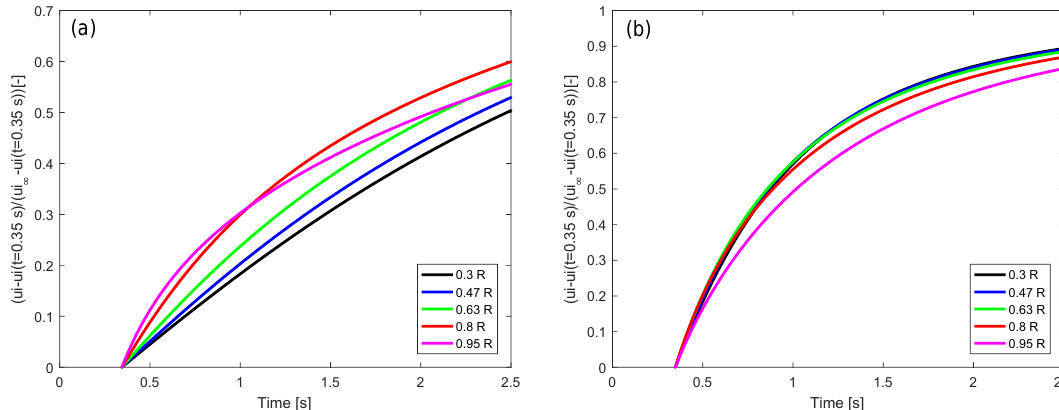
Figure 5. Scaled induced velocities predicted by the cylindrical wake model for the deloading (a) and loading (b) of the rotor. The scaling is such that the velocities range from 0 at the time instant just after the maximum force overshoot (indicated by dashed vertical lines in Fig. 3) to 1. The scaled induced velocities show the same qualitative trends as observed in the force measurements; see Fig.